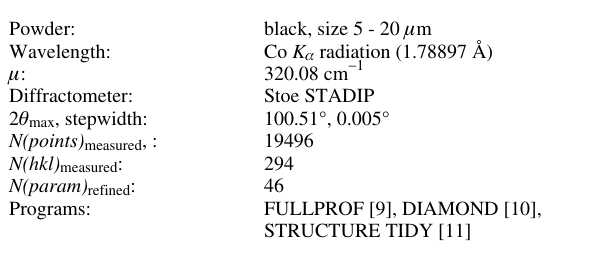
Table 1. Data collection and handling.